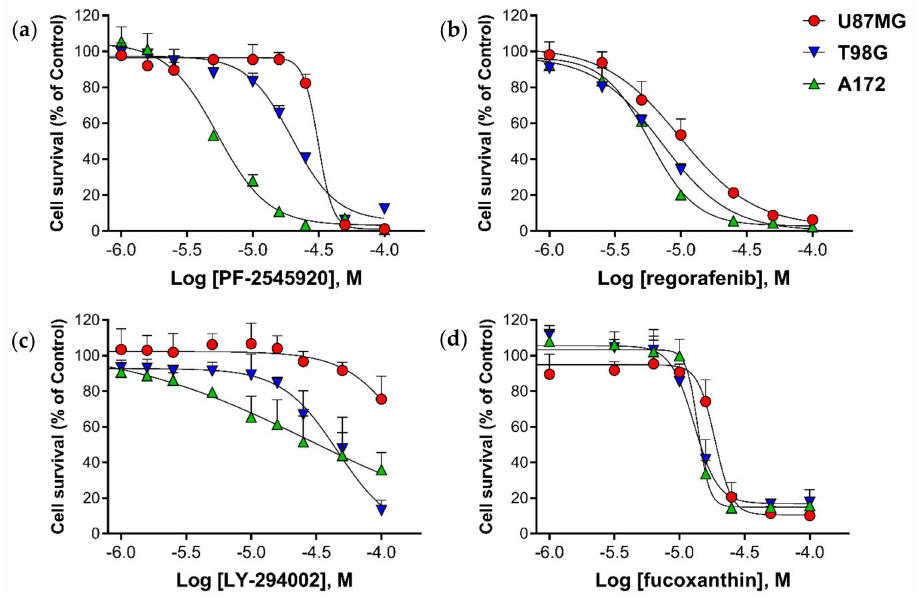
Figure 1. Survival of the three human GBM cell lines U87MG, A172, and T98G, treated with ( a ) Mardepodect (PF-02545920); ( b ) Regorafenib; ( c ) LY-294002; ( d ) Fucoxanthin. Data are presented as the mean ± standard error of the mean (SEM) ( n =